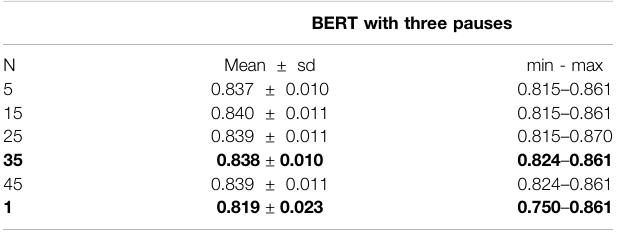
TABLE 2| Ensemble improves LOO (leave-one-out) estimates ofaccuracy; better means with less variance.